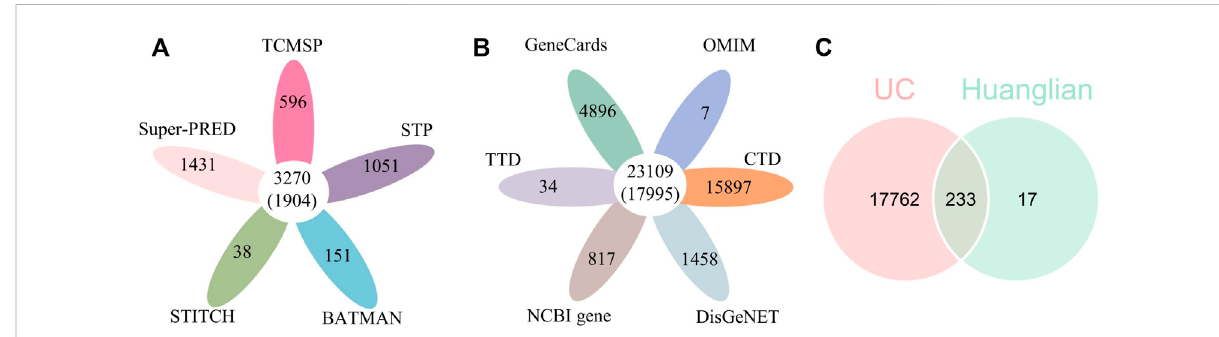
total of 623 GO terms for biological processes were obtained, the top 20 count and the top 20 fold enrichment results were visualized using a histogram and a bubble diagram (Figures 4A,B). Considering that enrichment analysis may include highly redundant information, simpli fi ed enrichment results performed by the R-package were displayed in Supplementary Figure S1. Biological process enrichment mainly contained the cellular response to interleukin-6, fi broblast apoptotic process, negative regulation of gene silencing by RNA, positive regulation of pro-miRNA transcription by RNA polymerase II, response to UV, fi broblast proliferation, T cell activation involved in immune response, positive regulation of interleukin-8 production, regulation of telomerase activity, and so on. In